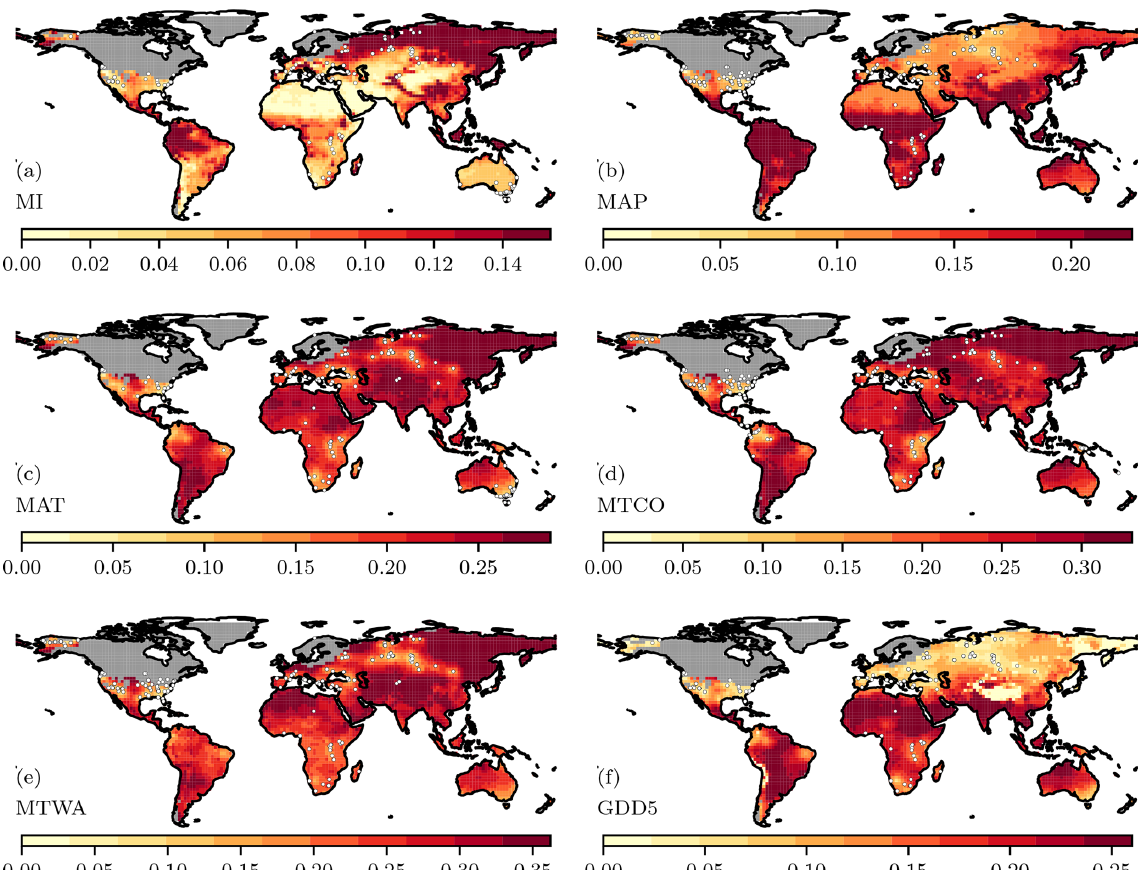
Figure 3. Uncertainties in the analytical reconstructions. These uncertainties represent a combination of the uncertainty in the site-based reconstructions and the grid-based variance in the prior and the global variance from the